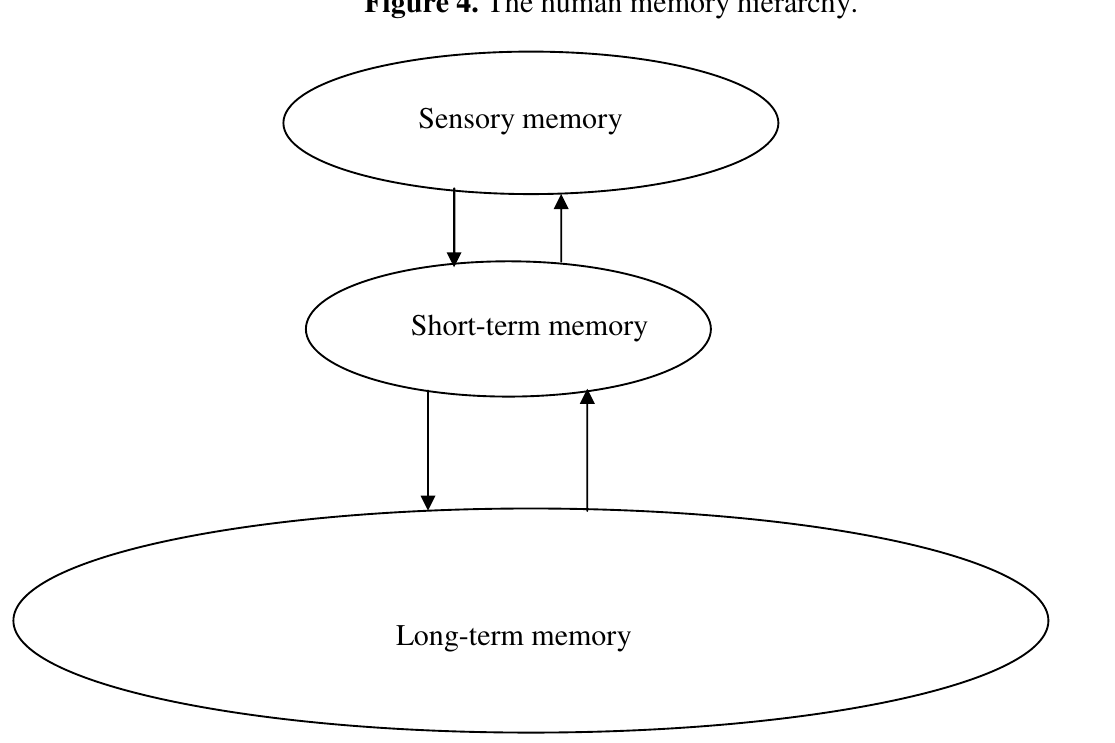
Figure 4. The human memory hierarchy.